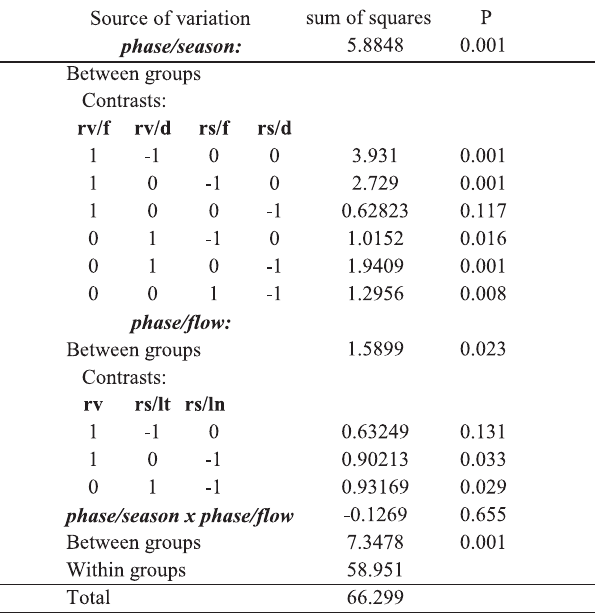
Table 2. Probabilities generated in the randomization test of the independence of diet composition of L. taeniofasciatus α≤ 0.05). Stomach from season and reservoir formation ( contents are assigned to groups defined by the combination of (1) phase/ season, and (2) phase/ flow.